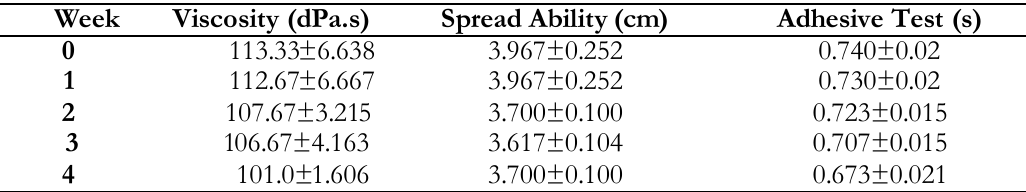
Table III. The viscosity, spread ability and adhesive ability of optimum o/w cream mahkota dewa